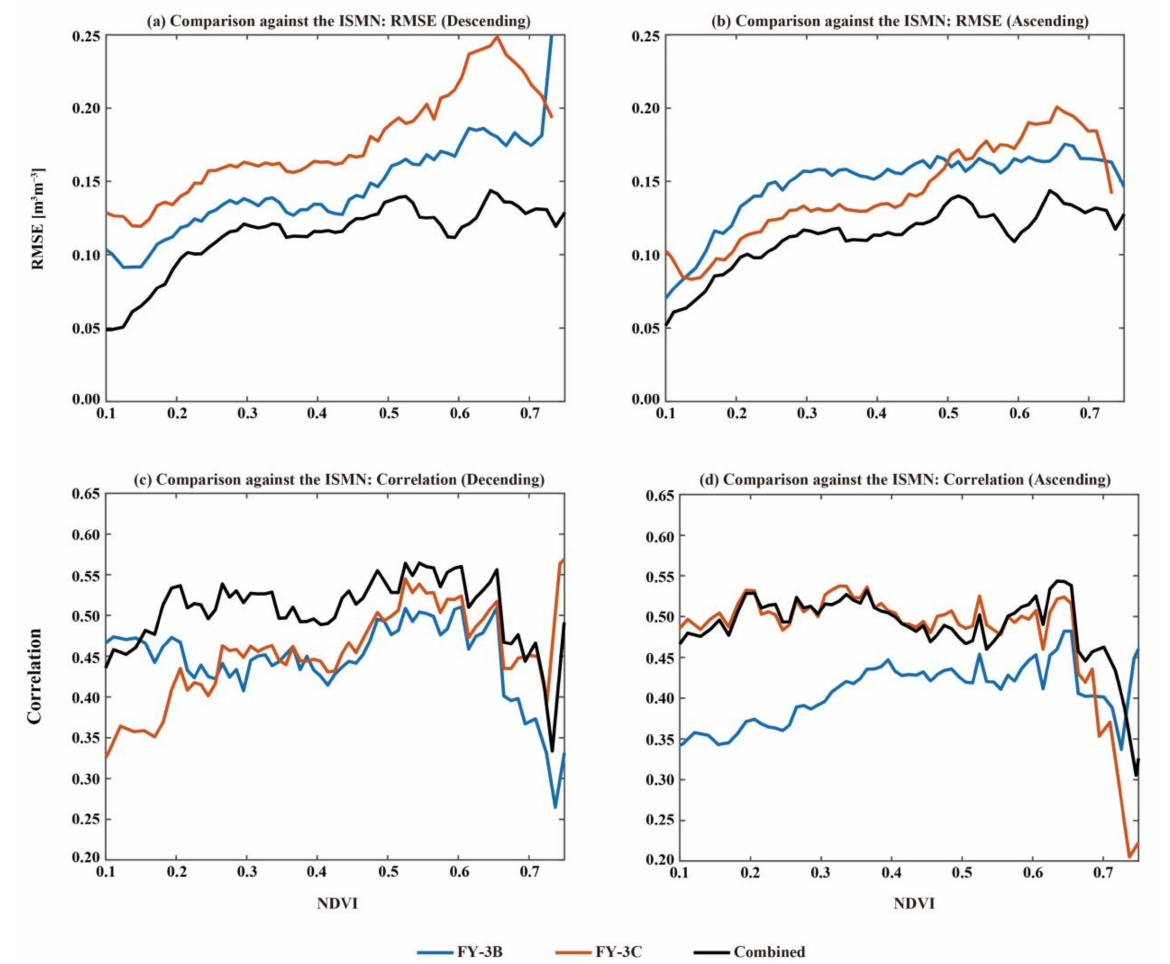
Figure 9. Showing improvements between in the combined soil moisture compared with FY-3B and FY-3C SM based on ( a ) RMSE for descending data (unit: m 3 m − 3 ); ( b ) RMSE for ascending data (unit: m 3 m − 3 ); ( c ) correlation for descending data; ( d ) correlation for ascending